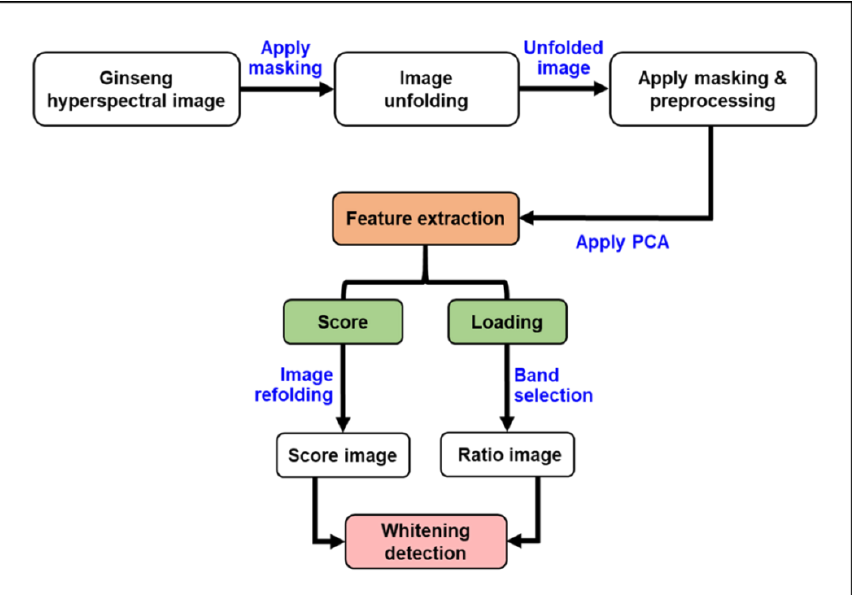
Figure 3. An illustration of hyperspectral image processing sequences used for whitening detection in ginseng.